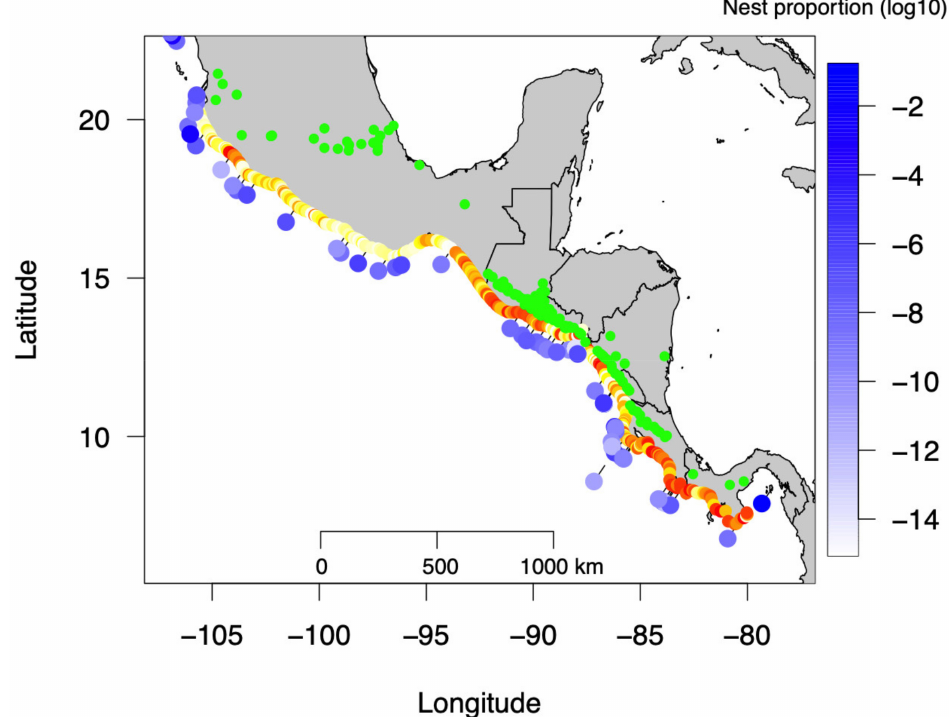
Figure 1. Map of Central America showing the recorded beaches with their estimated darkness (light yellow dots correspond to white sand with a higher albedo and red dots to darker sand with a lower albedo). Green points indicate the position of Holocene volcanos. Blue dots indicate the log10 proportion of olive ridley